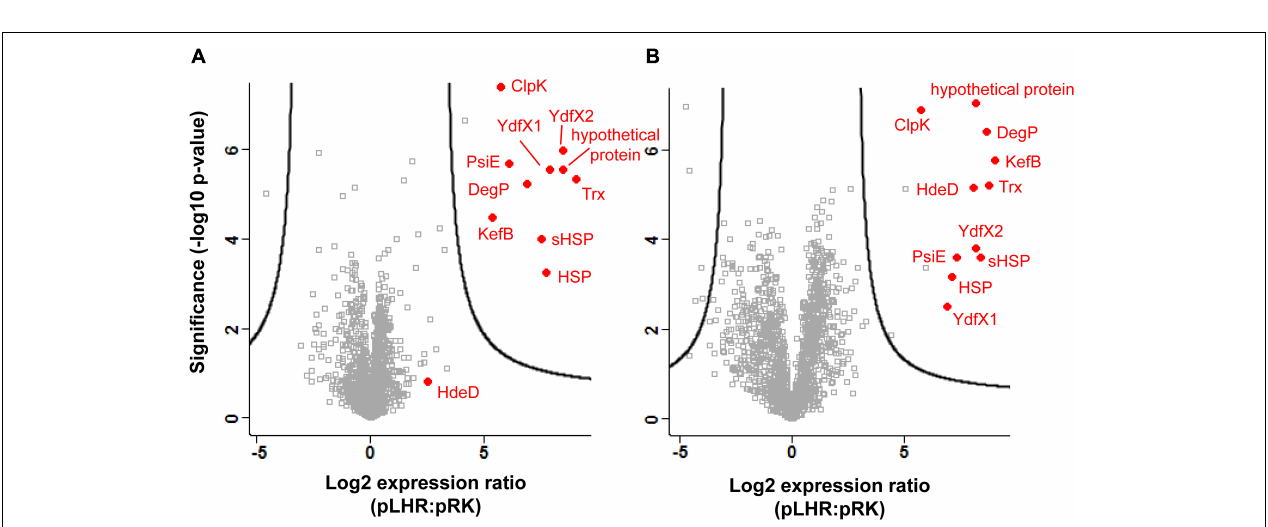
FIGURE 2 | Abundance of proteins expressed in E. coli MG1655 ibpA-yfp (pLHR). (A) Whole cell extracts; (B) inclusion bodies. Gray squares: background proteome; red dots: proteins expressed by the LHR. Proteome analyses were performed in quadruplicate independent experiments with technical repeats for each sample.